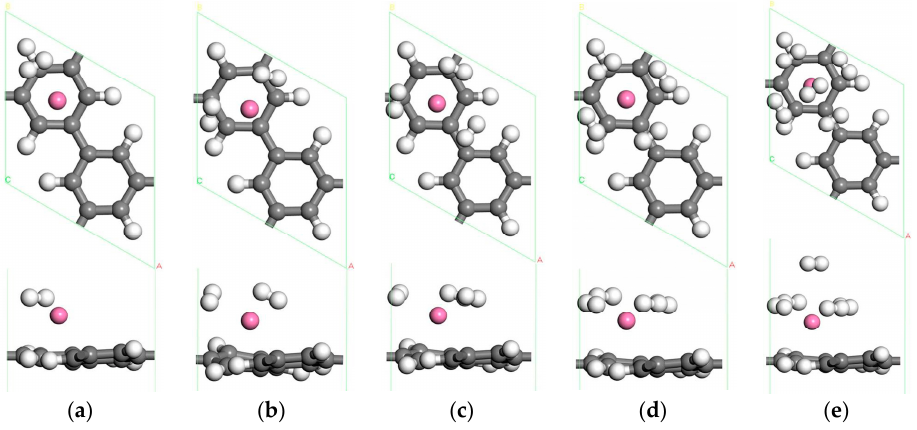
Figure 4. The optimized atomic structures of the Sc atom decorated PG with ( a ) one H 2 molecule; ( b ) two H 2 molecules; ( c ) three H 2 molecules; ( d ) four H 2 molecules; ( e ) five H 2 molecules adsorbed. Table 1. The adsorption energy, average adsorption energy and the nearest distance between Sc and C of porous graphene for H 2 adsorbed on single Sc decorated PG.